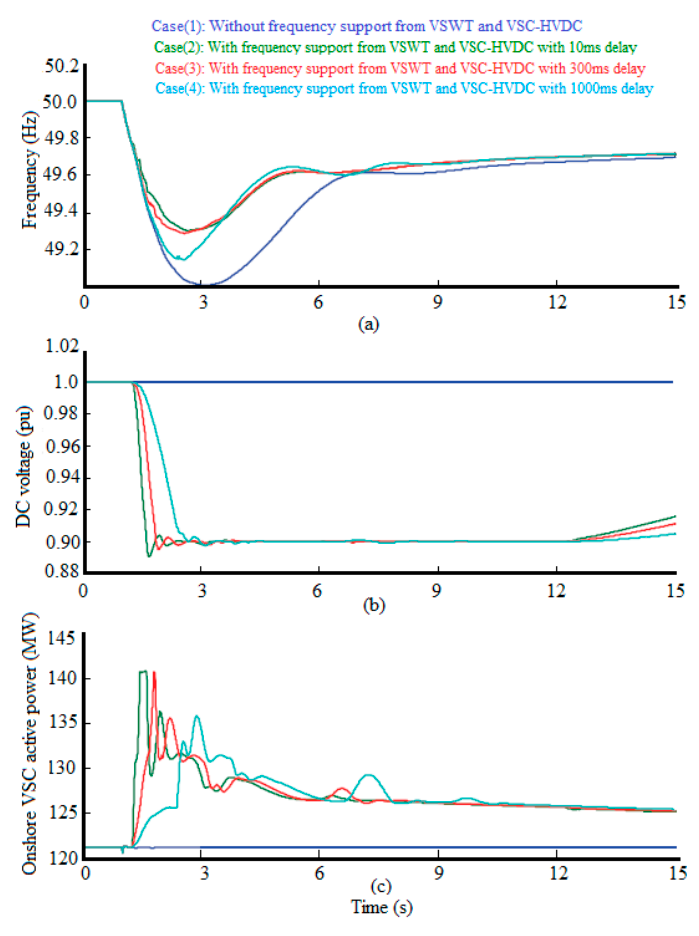
Figure 25. The influence of time communication delays for an unexpected increasing load; ( a ) AC grid frequency response; ( b ) DC link voltage; and ( c ) onshore VSC active power production.